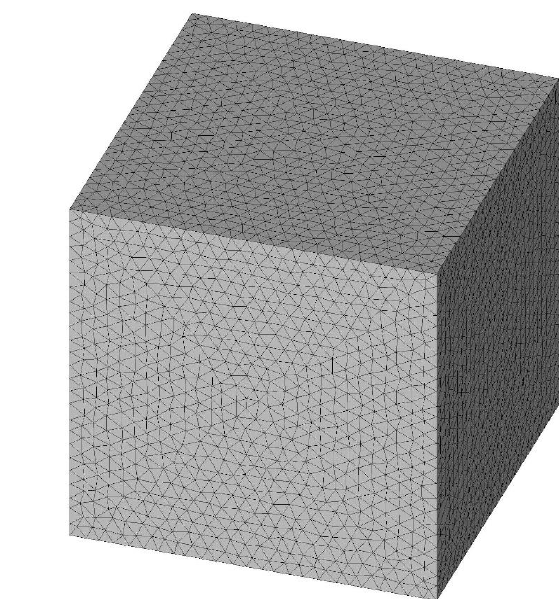
(a) Coarse mesh, 7674 elements, 1635 nodes. (b) Fine mesh, 63595 elements, 11928 nodes. Fig. 5. 3-D Four-noded tetrahedral solid elements and typical 3-D